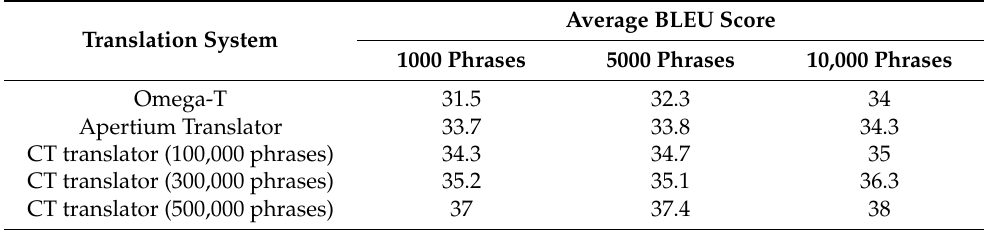
Table 6. Automated evaluation using F mean Score, for the English-French